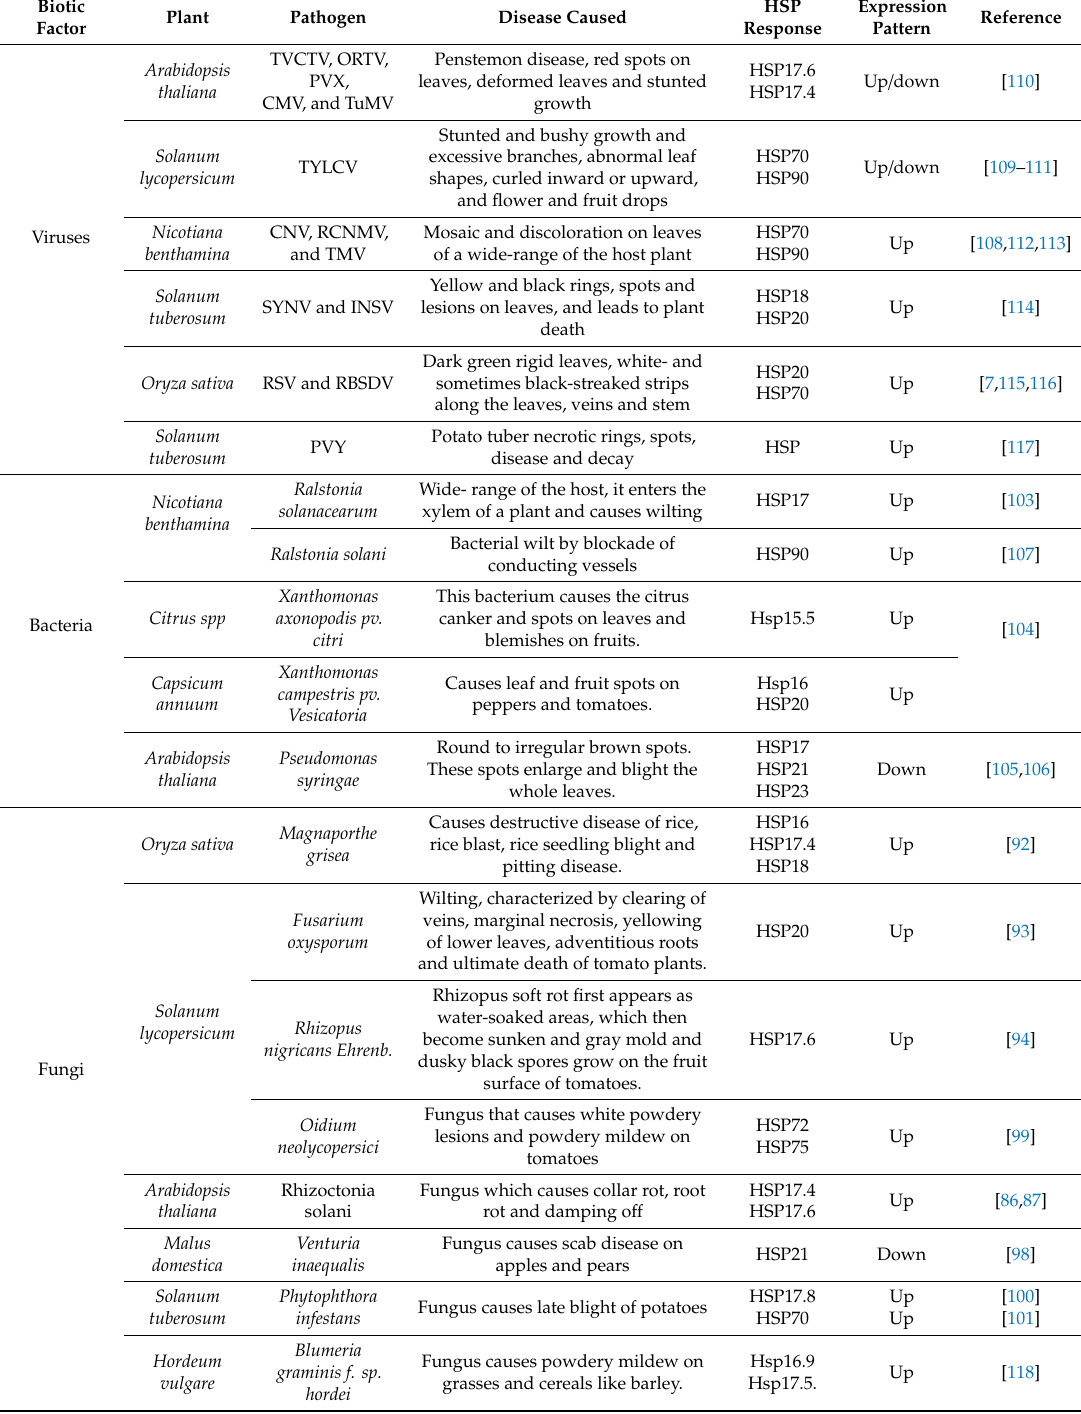
Table 2. Summary of the role of plant HSP under biotic